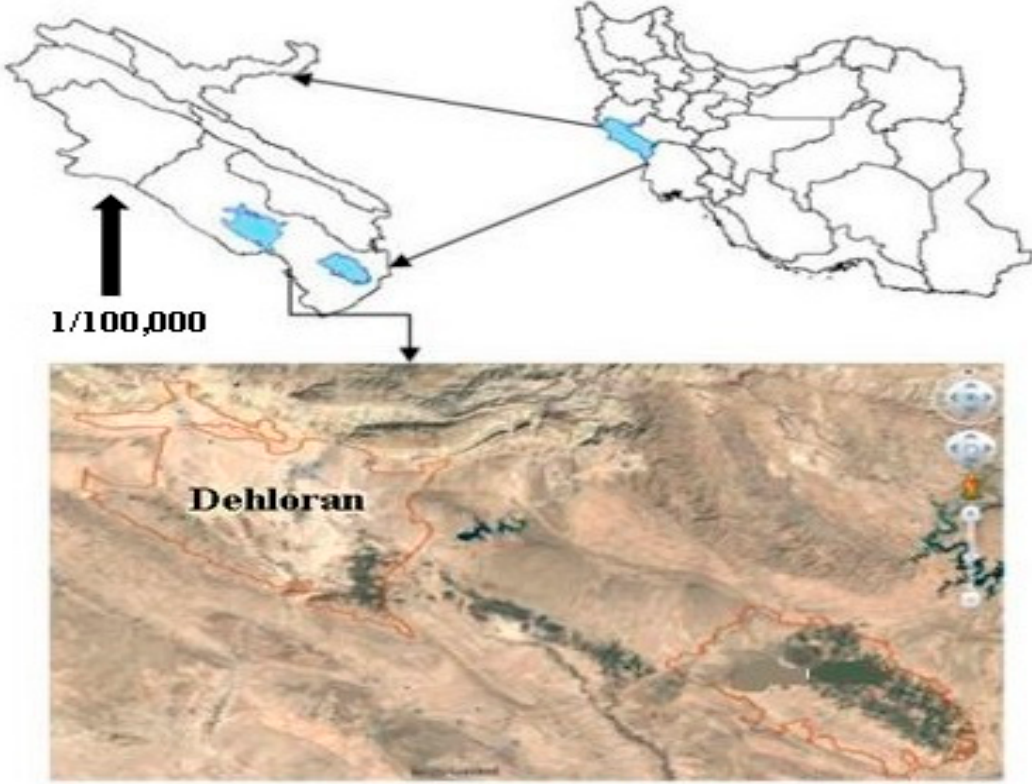
Figure 1. Location map of the study area in Iran—Ilam Province.